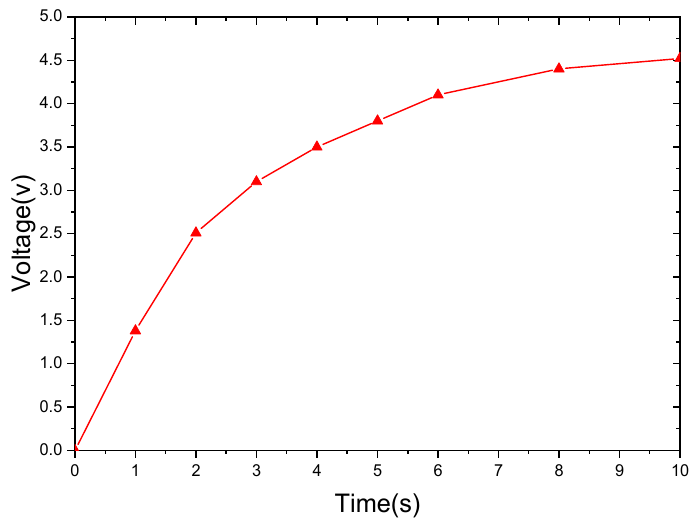
Figure 13. Charging behavior using LTC3588 ( a = 0.7 g, d = 1.5 cm). After connecting, as shown in Figure 14a, the tuning fork energy harvester can produce a stable output and cause the humidity sensors to work, as shown in Figure